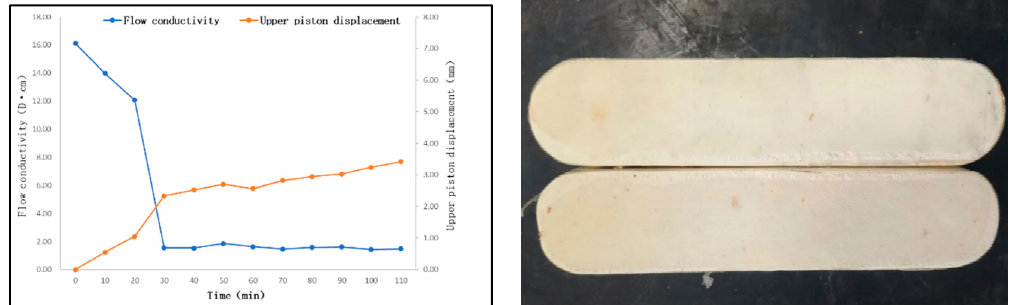
Figure 13. Variation curve of saline fracturing fluid conductivity and dissolution pattern of the rock slab.